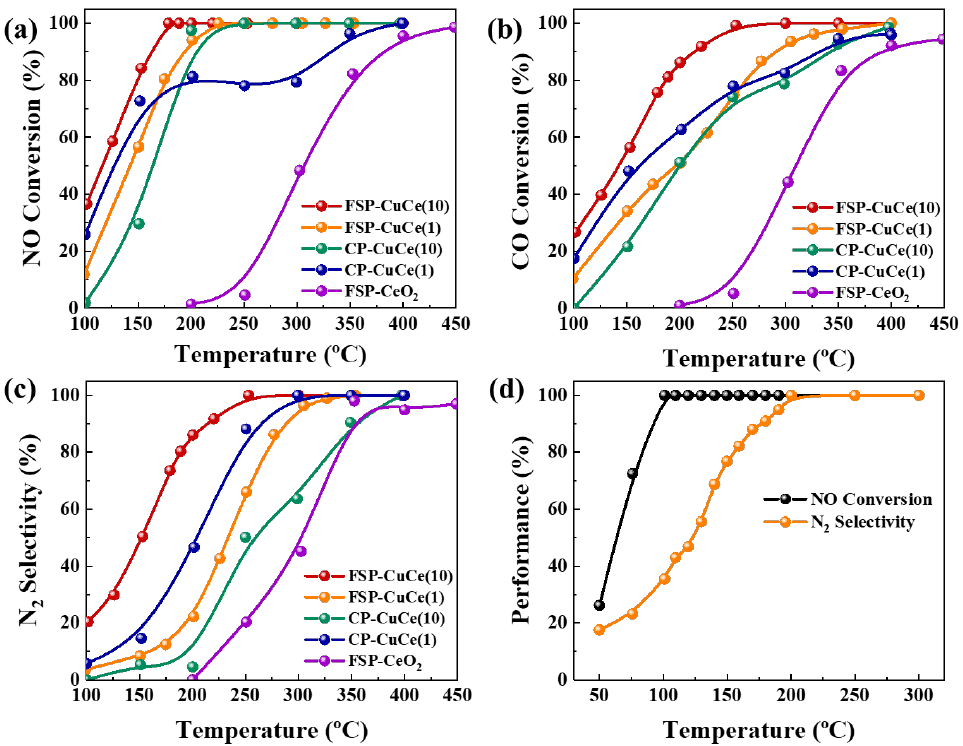
Figure 1. Comparison of catalytic performance of CuCe catalysts synthesized by FSP and CP methods with Cu weight percentage of 1% and 10% over NO + CO reaction (5%NO+5%CO+90%He): ( a ) NO conversion, ( b ) CO conversion and ( c ) N 2 selectivity. ( d ) The performance of FSP-CuCe(10) sample in 1%NO+2%CO+97%He reaction atmosphere.